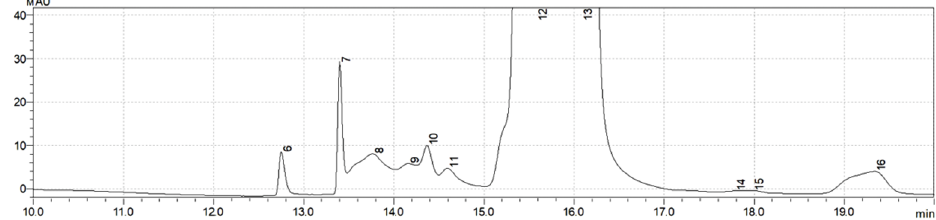
Figure 3. HPLC of the main polyphenols in Amelanchier ovalis : peaks 3 and 4 are derivatives of chlorogenic acid (320 nm).